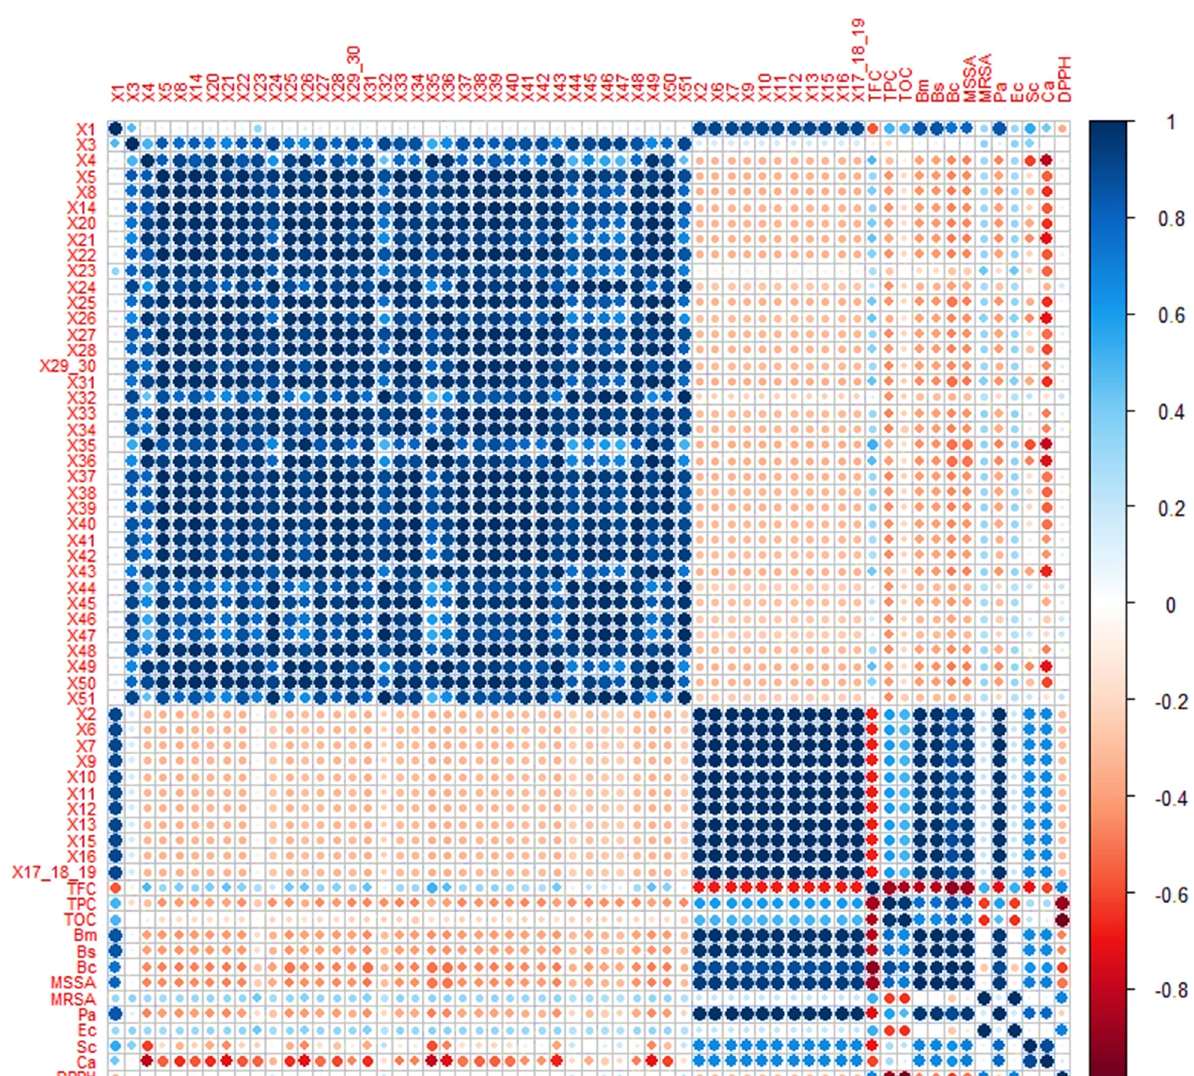
Figure 2. Correlation plot of the chemical composition and bioactivities of the propolis extracts. Dark blue (positive correlation) and dark red (negative correlation) show the strength and direction of the correlations between the variables. DPPH : DPPH free-radical-scavenging activity expressed as a mean of EC 50 values (µg/mL); TFC : total flavonoids content; TPC : total phenolics content; TOC : as a mean of EC 50 values ( µ g/mL); TFC : total flavonoids content; TPC : total phenolics total ortho-diphenols content; Microorganisms— Bs : Bacillus subtilis ; Bc : Bacillus cereus ; Bm : Bacillus megaterium ; MSSA : methicillin-sensitive Staphylococcus aureus ; MRSA : methicillin-resistant Staphy- lococcus aureus ; Pa : Propionibacterium acnes; Ec : Escherichia coli ; Sc : Saccharomyces cerevisiae ; Ca : Can- dida albicans —distributed according to the MIC values; x1–x51 : compounds detected by UHPLC- DAD-ESI/MS n analysis (see Supplementary Material Table S1).